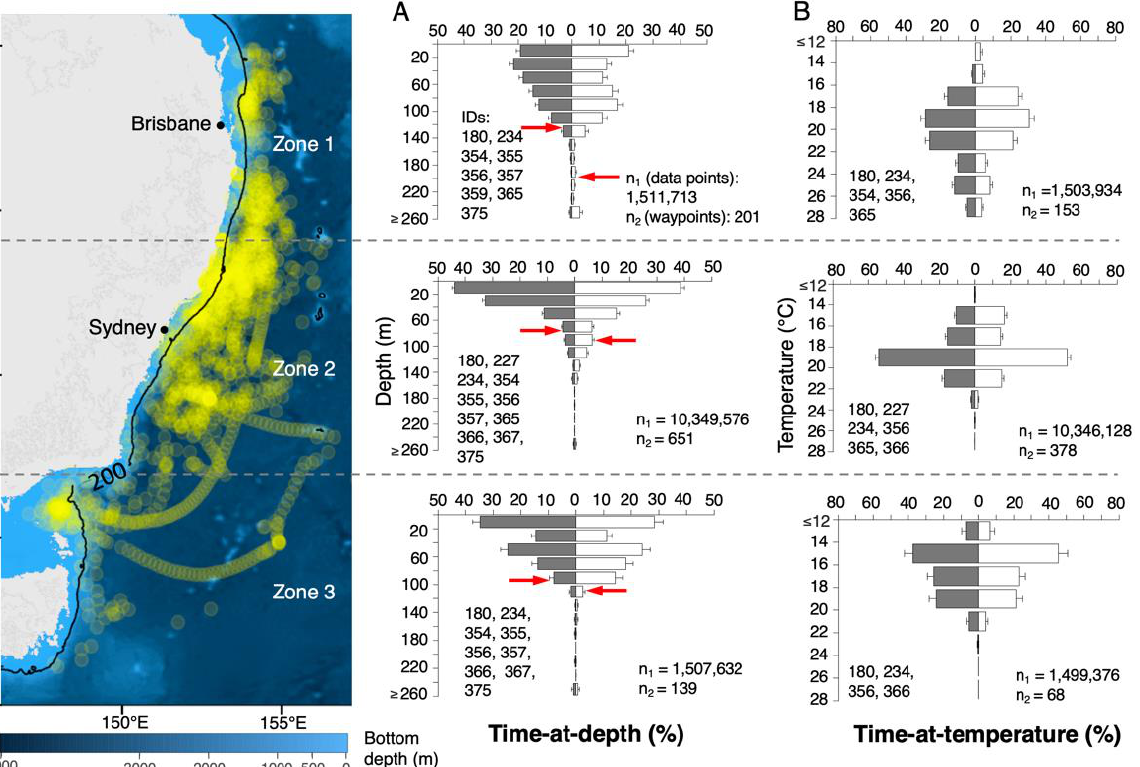
Figure 2. Depth and temperature occupation by latitudinal zones (north, central and south). Yel- low dots represent positional data of all individual tracks ( n = 12) displayed in Figure 1. ( A , B ) indicate percent time at depth and temperature by day (white bars) and night (grey bars) from Pop-Up Satellite Archival Transmitting tags (PSAT) data for each latitudinal zone. Error bars represent SDs. ‘IDs’ indicates the ID numbers of sharks for which depth and temperature records were included in each histogram. n 1 and n 2 indicate the number of depth and temperature records and the number of waypoints (points along estimated tracks) included in each histogram, respectively. Sharks for which depth or temperature data were missing for more than 25% of the total deployment days were excluded from the analyses. Red arrows indicate depth above which 95% of data occur for both day and night. Depth > 250 m were included into the 240–260 m bin. Temperatures < 12 ◦ C were included into the 12–14 ◦ C bin. For shark 180, all available depth and temperature data were included into the analysis, even though the full track of this shark is not shown in the zoomed-in map. The map was generated using the marmap package in R